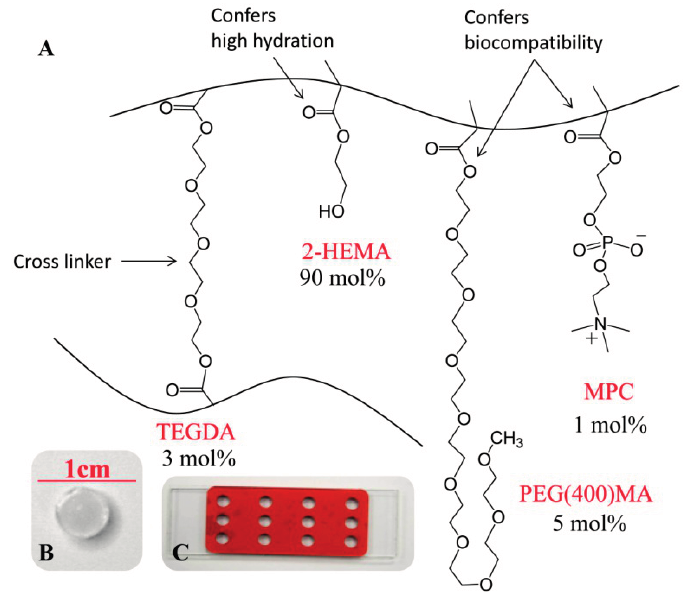
Figure 1. ( A ) Schematic of the molecular structure and mol% composition of the pre-polymer constituents of poly(HEMA)-based hydrogel possessing MPC, OEG(400)MA and cross-linked with 3 mol% TEGDA; ( B ) Hydrated hydrogel disc; and ( C ) Isolation chamber used for disc preparation sandwiched between two